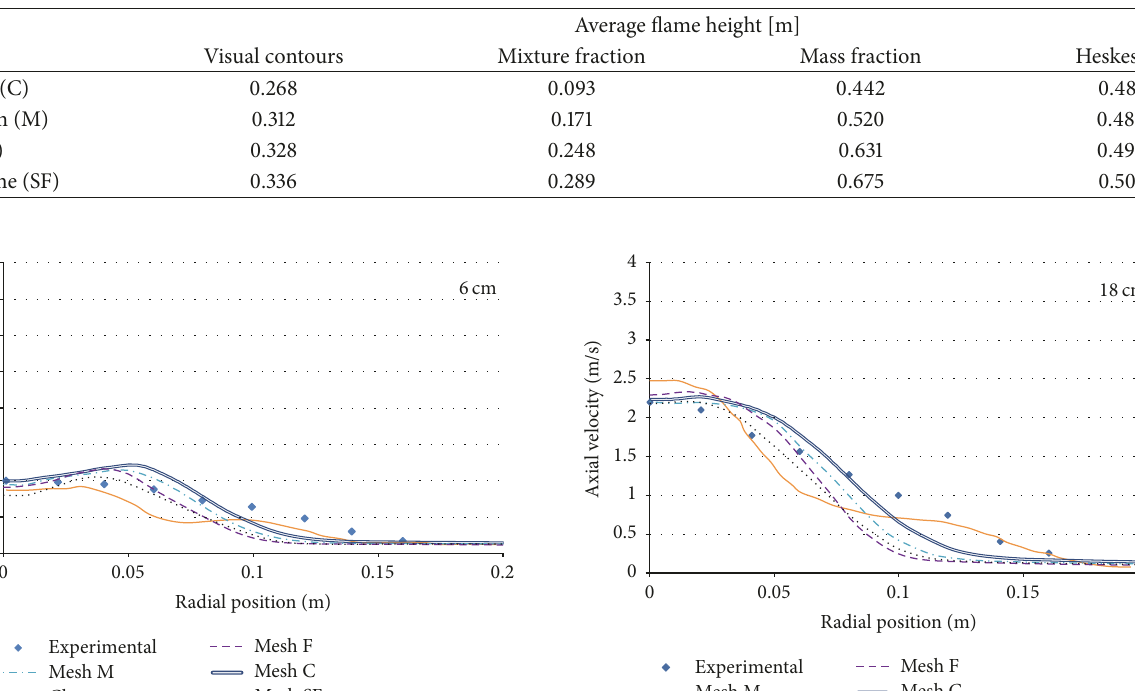
Table 3: Mesh convergence.